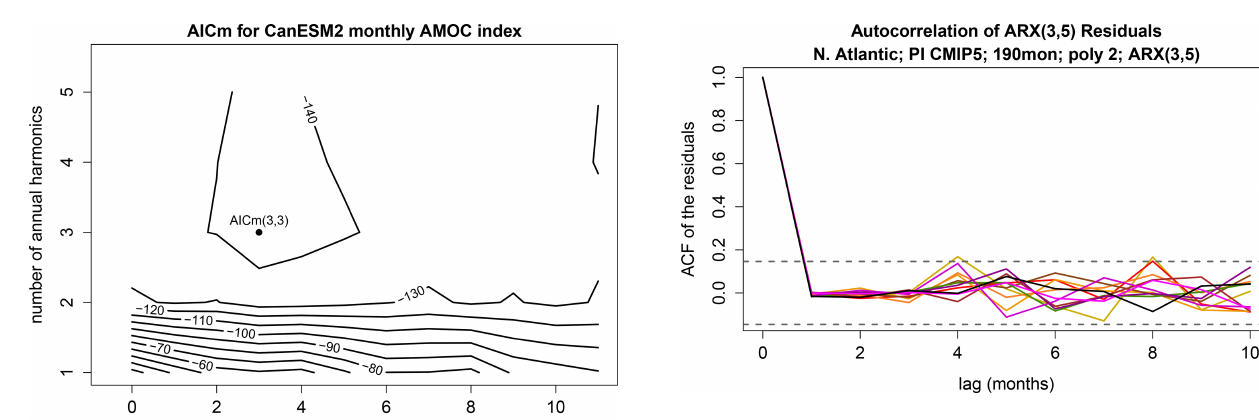
Figure 5. The autocorrelation function of the residuals of the ARX models. The horizontal dashed lines show the upper and lower 5% confidence limits for zero correlation.